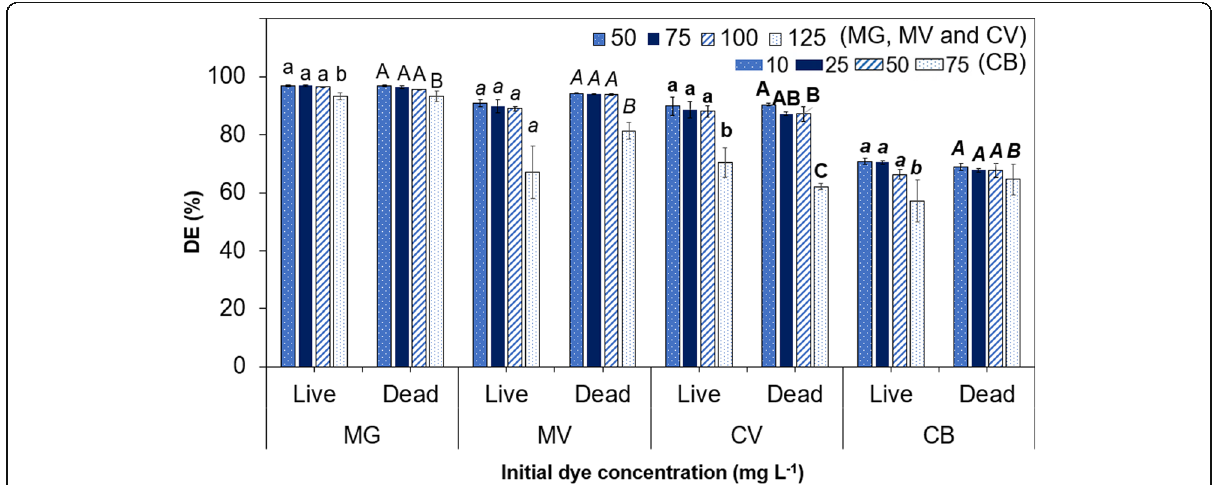
Fig. 7 Effect of initial dye concentrations on the DE of TPM dyes by Streptomyces isolate (live and dead cells). Means with the same letters (lowercase, live cells; uppercase, dead cells) and font style (MG, regular; MV, italic; CV, bold; CB, bold italic) are not significantly different at HSD ( 0.05 ). Bars indicate ±